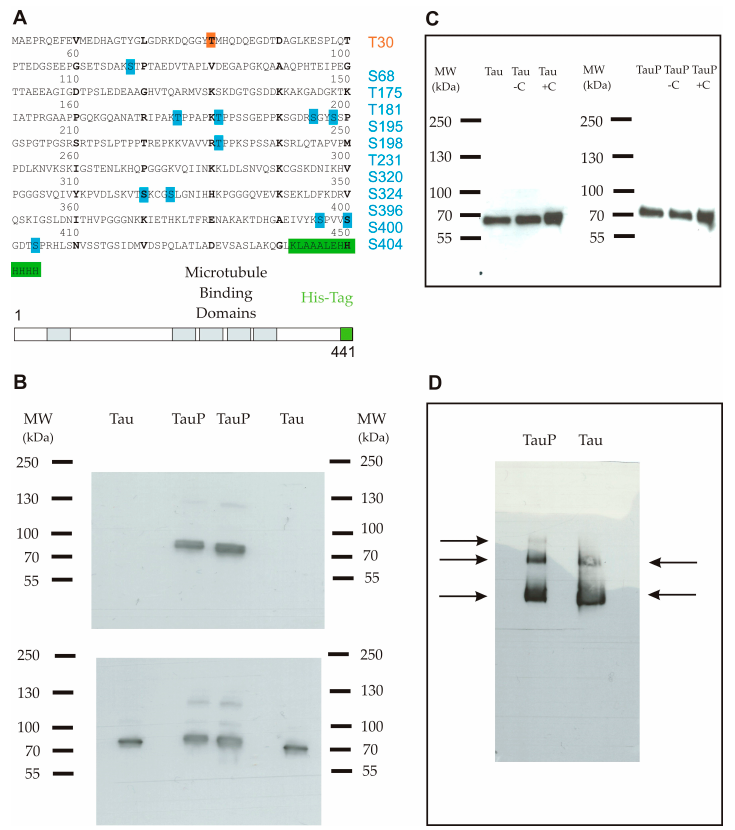
Figure 1. ( A ) Primary sequence of the full ‐ length recombinant monomeric Tau protein 1 ‐ 441 isoform (2N4R) coupled with a C ‐ terminal His ‐ tag (6× His). The protein comprised one phosphorylation site for the low phosphorylated form (orange) and 11 phosphorylation sites for the highly phosphorylated form (blue); ( B ) Western blot using an anti ‐ phosphoT231 antibody. Upper panel shows a band only for the highly phosphorylated form. Lower panel is a control with an anti ‐ Tau antibody and shows that both proteins were correctly loaded in duplicate; ( C ) Western blot using an anti ‐ His ‐ tag antibody shows that the Tau protein remained in a monomeric form in the purified stock (well 1), after an incubation of 6 h in medium only (well 2) and after an incubation of 6 h in the presence of cortical cells (C) (well 3) for low (left) and highly phosphorylated (right) Tau proteins; ( D ) Blue native polyacrylamide gel electrophoresis (BN ‐ PAGE) followed by immunodetection using an anti ‐ Tau antibody shows three bands for the highly phosphorylated form (from the top ‐ down: trimers, dimers and monomers) and two bands for the low phosphorylated form (from the top ‐ down: dimers and monomers).